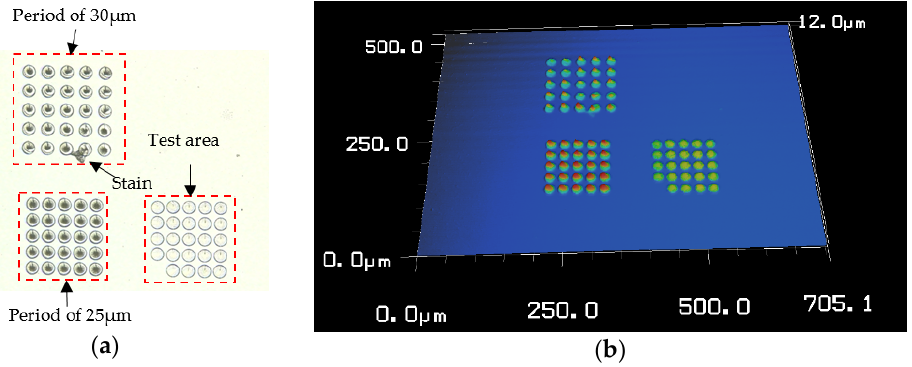
Figure 4. Measured overall morphology of the sample fabricated. ( a ) Two-dimensional topography, and ( b ) three-dimensional topography.